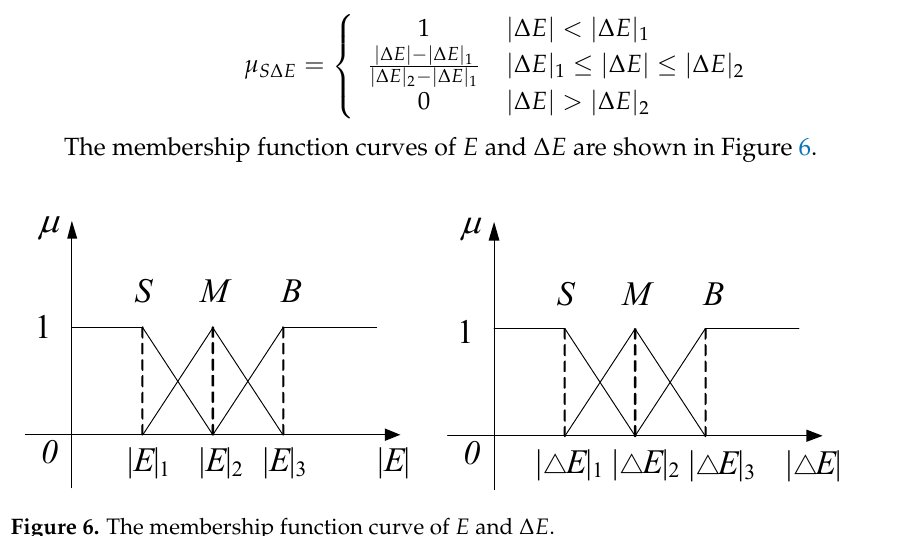
Figure 6. The membership function curve of E and ∆ E